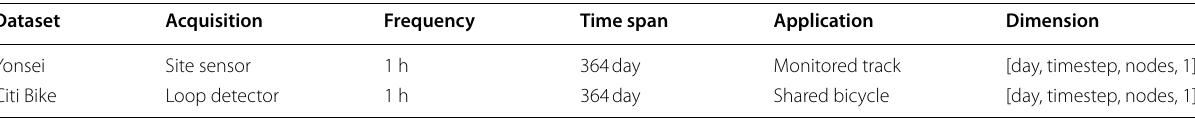
(1) The Yonsei dataset comprises pedestrian trajectory data generated by nine graduate students over a two-month period in 2011 using a cell phone location service application called SmartDC. The data were collected in Yonsei University in Seoul, South Korea. The data size is [33203, 4], and the data features contain person_id, time, latitude, and longitude (2) The Citi Bike dataset comprises bike-sharing trajectory data across more than 600 stations in Toronto, Canada, in 2016. We used data features including time, latitude, and longitude